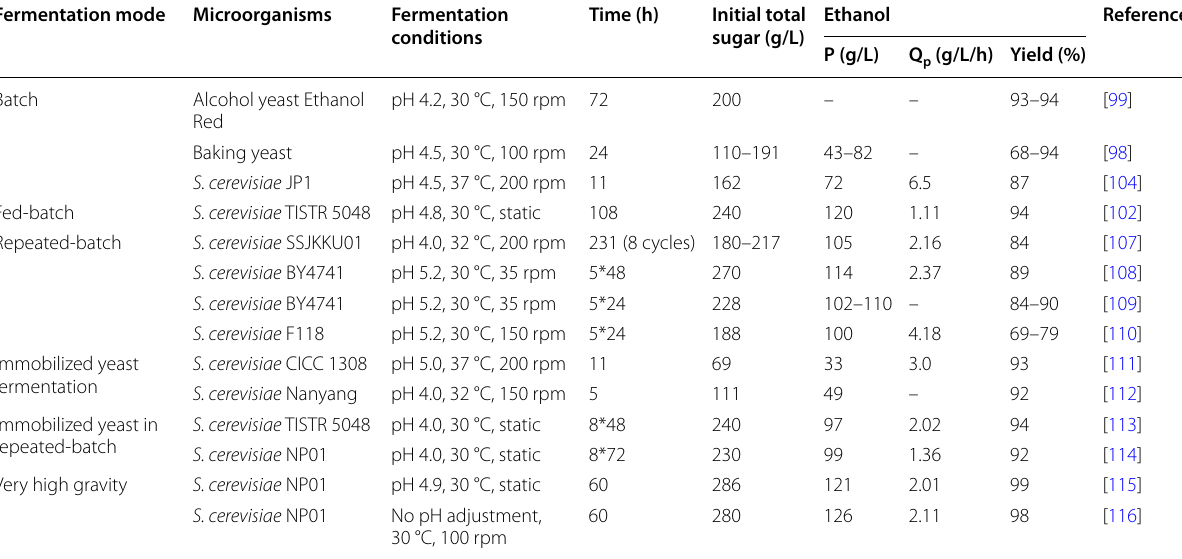
* P, ethanol concentration; Q p , volumetric ethanol productivity